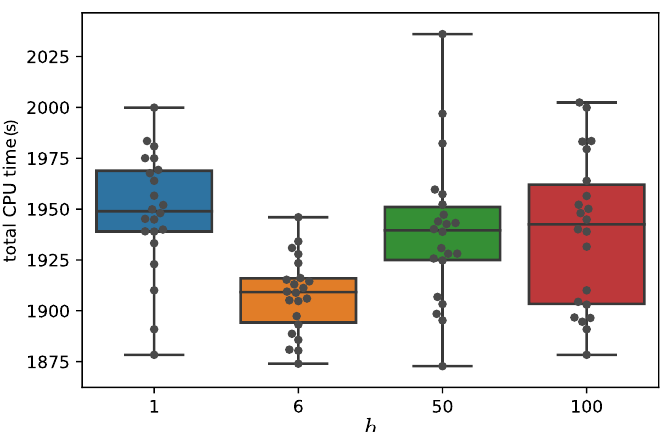
Figure 4: Computation time for various disorder strengths and L = 20, using STRUMPACK with a full MPI strategy. For each disorder strength the computation was carried out for 22 disorder realizations, shown as individual points on the plot. The whiskers span the whole time distribution, while the bottom (top) of the boxes correspond to the first (third) quartile. The median value is shown as a solid